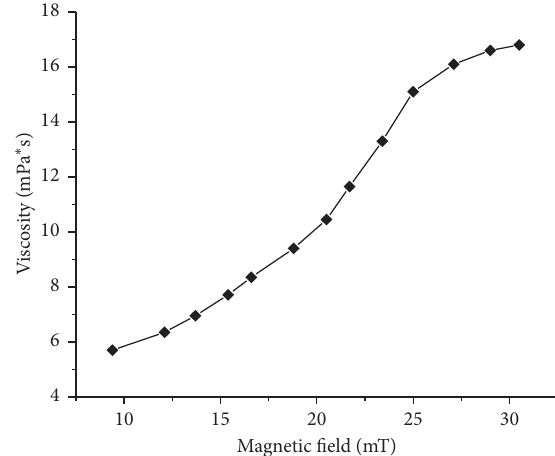
Figure 2: The magnetoviscous characteristic